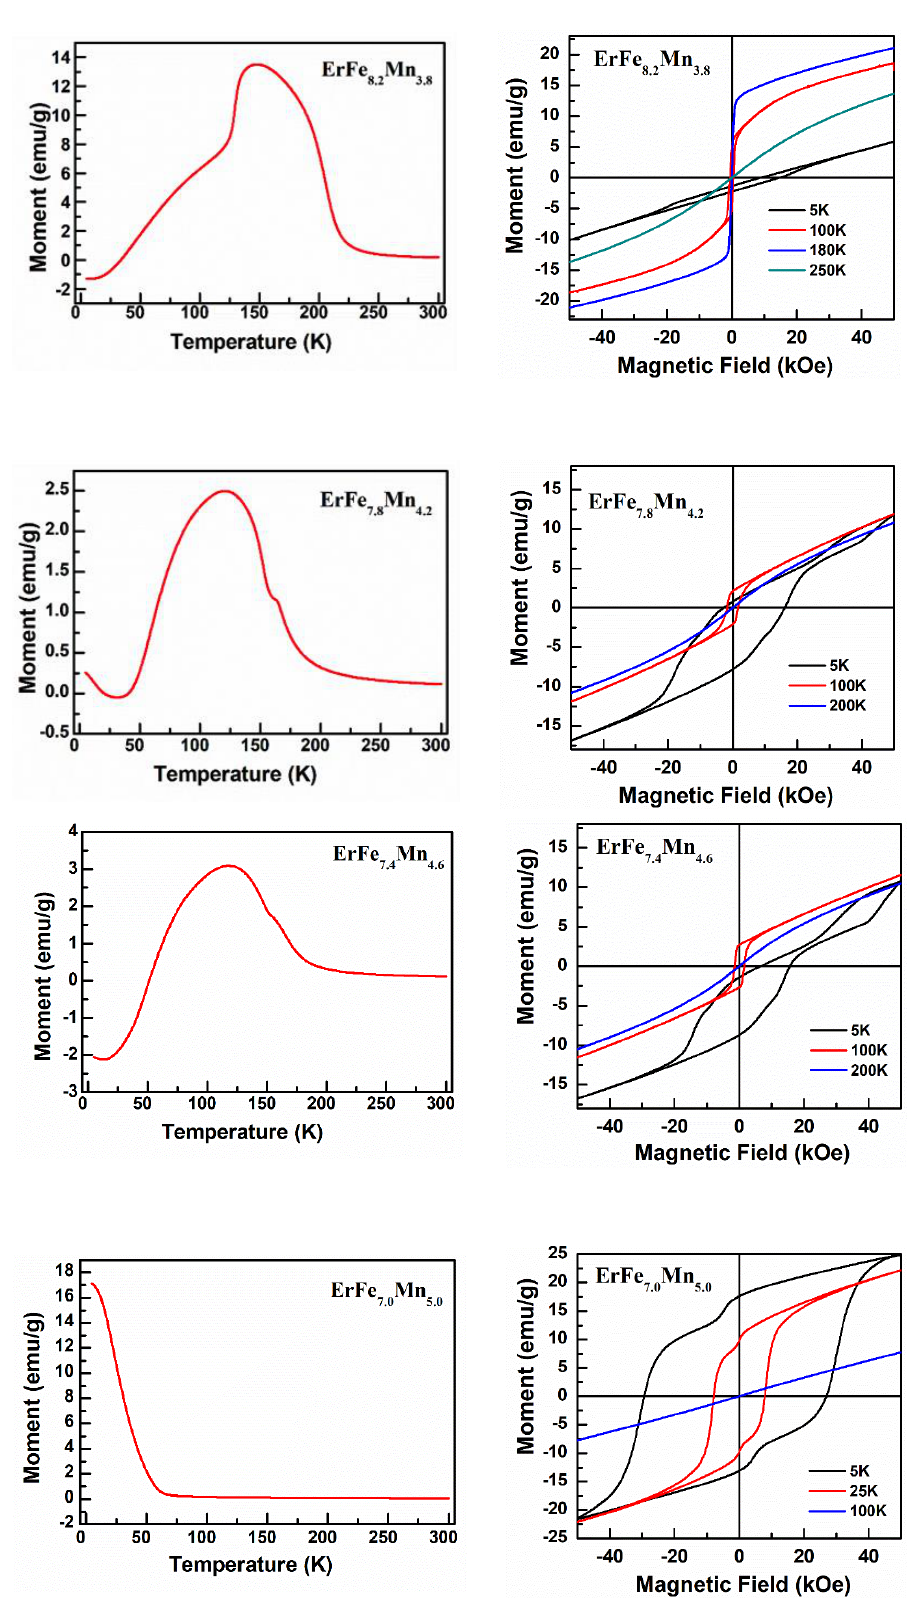
Figure 5. M − T curve under field cooling condition (H = 1000 Oe) and M − H curve after 1000 Oe field cooling of ErFe x Mn 12 − x (7.0 ≤ x ≤ 9.0) series alloys.